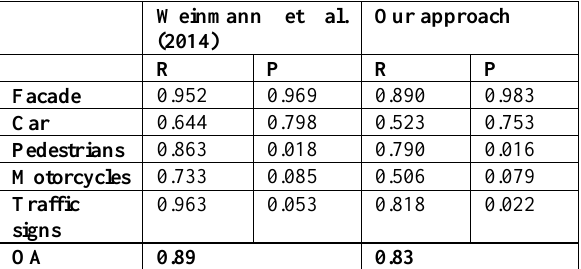
Table 3. Recall and Precision between existing work and proposed work and overall accuracy (OA: overall